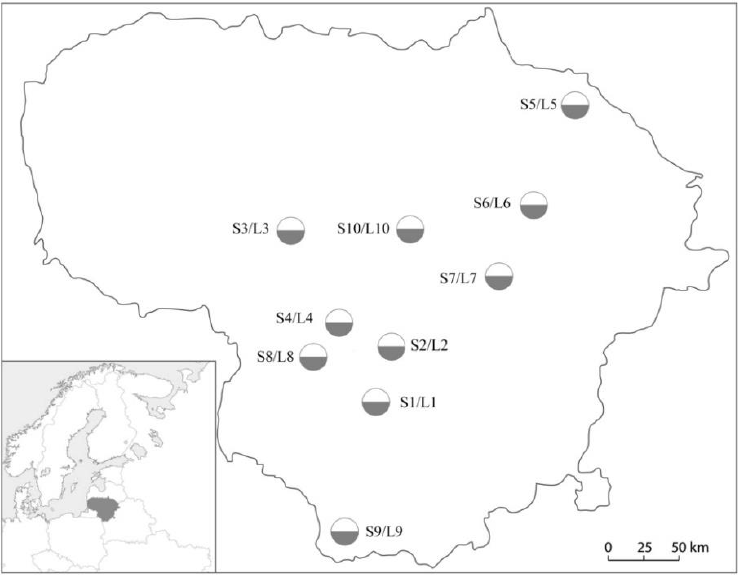
Figure 1. Map of Lithuania showing the distribution of study sites. Gray color in the circle indicates Larix sp. stands (L1 – L10), and white color represents P. abies stands (S1 – S10).